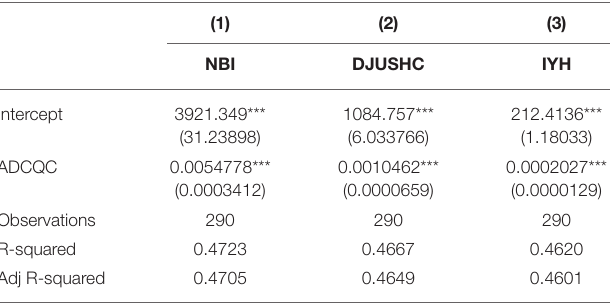
TABLE 7 | OLS regression analysis results.